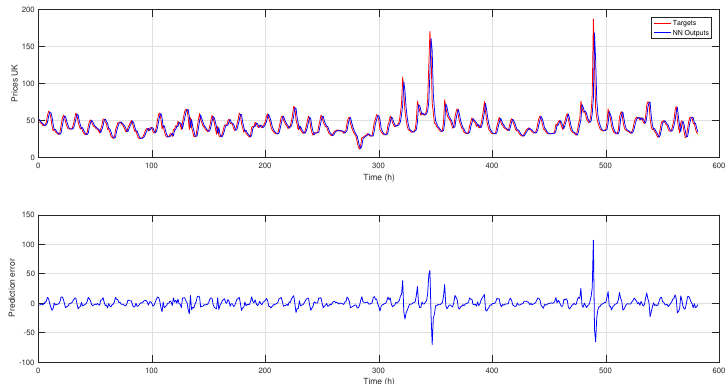
Figure 12. Energy price forecasting for the United Kingdom time series